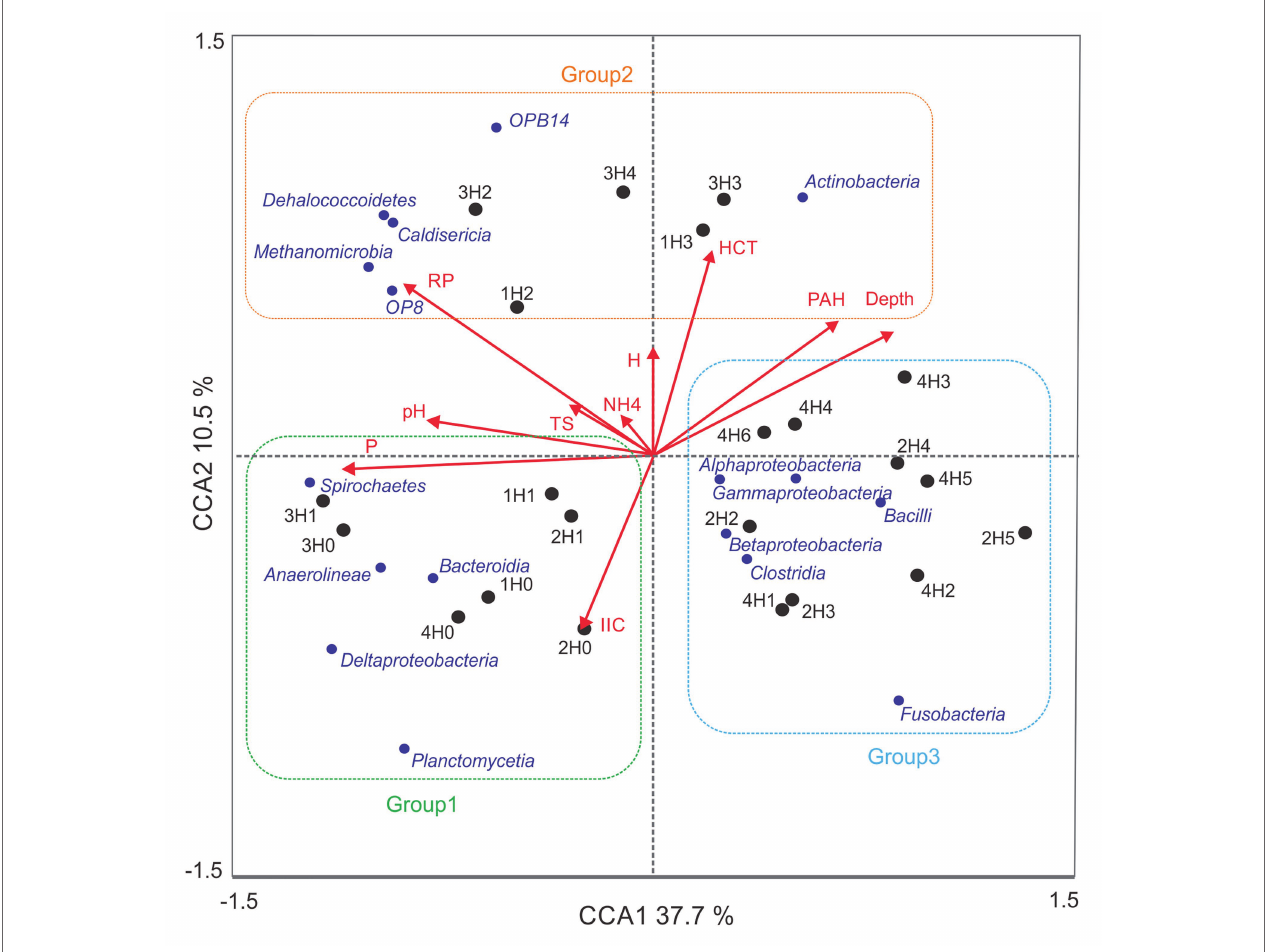
FIGURE 4 | Canonical correspondence analysis of microbial community composition and environmental variables. Content of available phosphorus (P), redox potential (RP), pH, polycyclic aromatic hydrocarbons (PAH), total hydrocarbons (HCT), cation exchange capacity (IIC), total sulfide (TS), water content (H), and exchangeable ammonium (NH4). CCA1: first axis, CCA2: second axis. Samples belonging to group 1, group 2, and group 3 are gathered together in green, orange, and blue squares, respectively. Samples and classes are represented with black and blue dots,